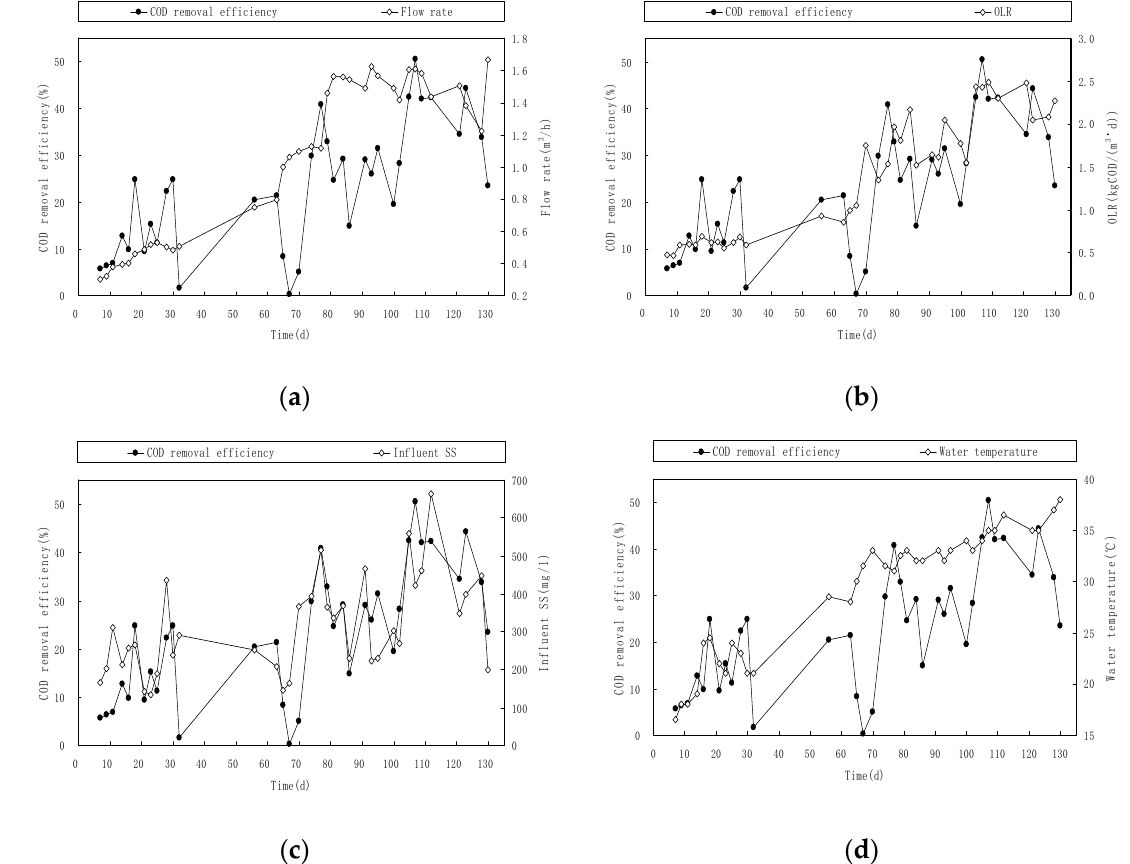
Figure 6. Time series of chemical oxygen demand (COD) removal efficiency with ( a ) flow rate; ( b) organic loading rate (OLR); ( c ) influent suspended solid (SS); ( d ) water temperature.